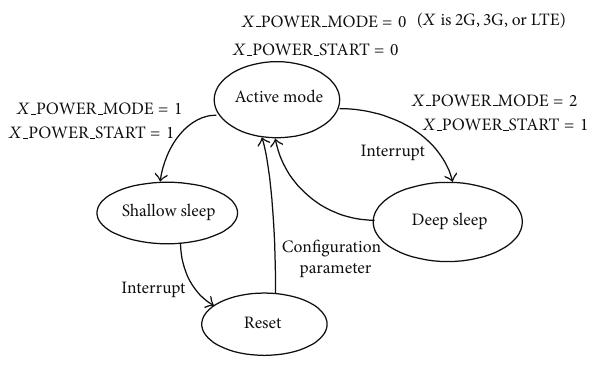
Figure 1: The state machine of power mode